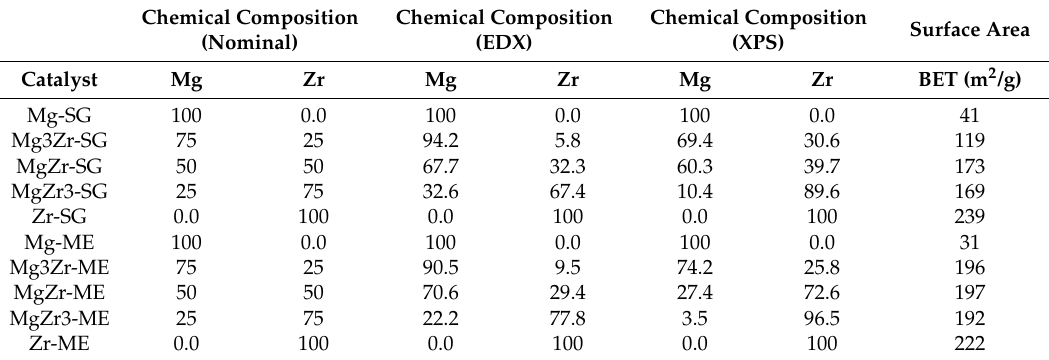
Table 1. Nominal, EDX and XPS chemical composition (%mol) and textural properties of the catalytic systems synthesized in this